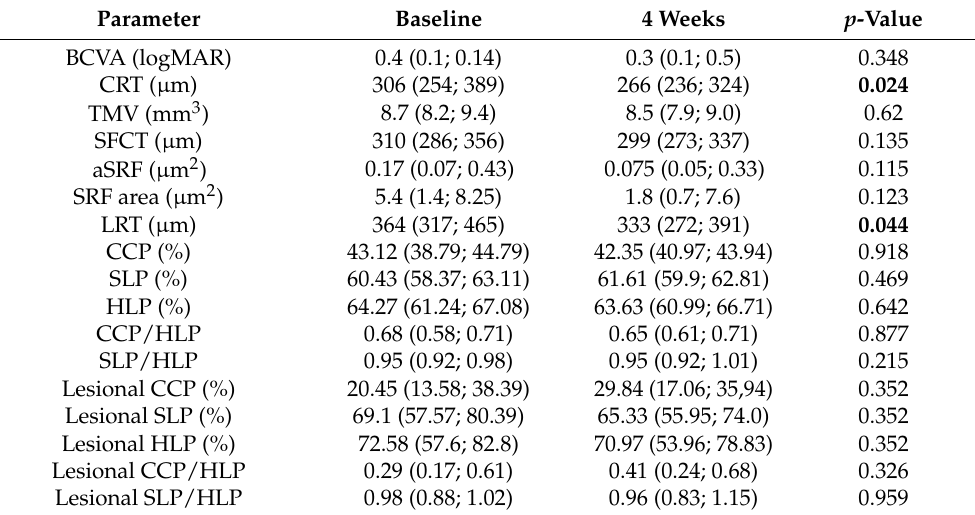
Table 3. Comparison of the anatomical and functional parameters before and 4 weeks after SML for all treated patients.